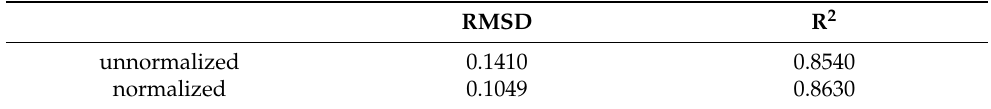
Figure 2. Comparison between individual pixel values of Landsat-8 NDVI and normalized/unnormalized GF-6 NDVI images. Table 3. Statistical parameters of individual pixel values of Landsat-8 NDVI and normalized/unnormalized GF-6 NDVI.